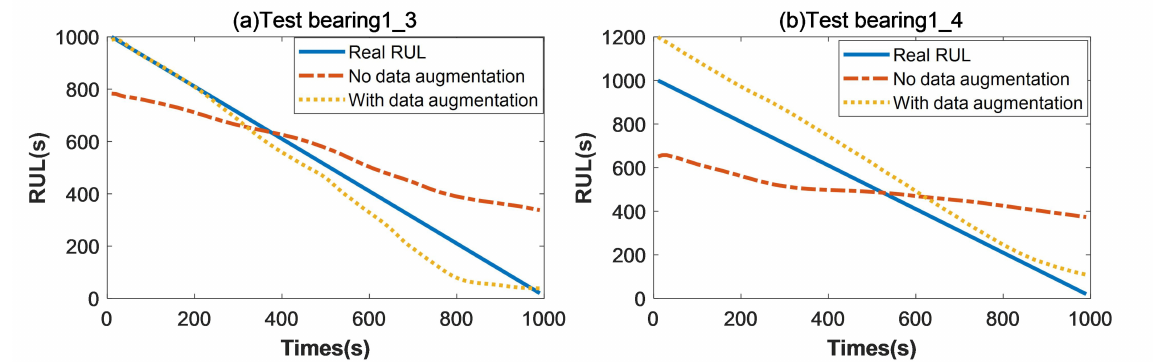
Figure 9. The comparison between Wiener–LSTM model with data augmentation and without data augmentation. ( a ) The predicted results on test bearing1_3. ( b ) The predicted results on test bearing1_4. The blue line is the real RUL from 1000–0 s. The red line is the predicted result by the Wiener–LSTM model without data augmentation. The orange line is the predicted result by the Wiener–LSTM model with data